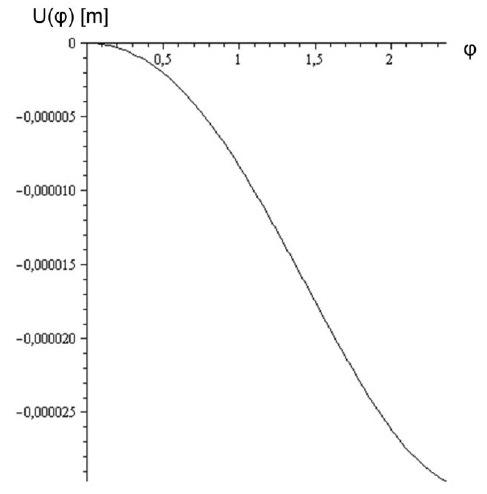
Figure 17: Plots of radial displacement for Example